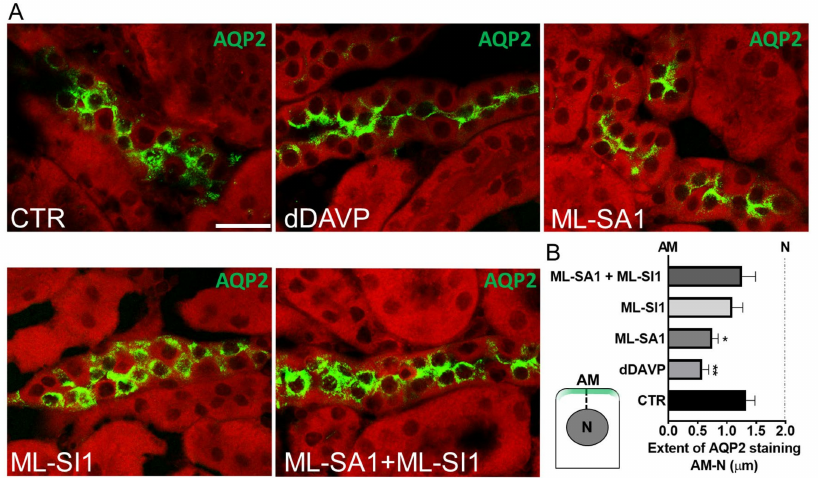
Figure 10. TRPML1 stimulation promotes AQP2 accumulation on the apical membrane of collecting duct cells of freshly isolated kidney slices. ( A ) Freshly isolated kidney slices from 6 wt mice were left untreated (CTR, complete medium) or stimulated for 45 min in complete medium as follows: 100 µ M dDAVP; 100 µ M ML-SA1 alone or after 30 min of preincubation with 25 µ M ML-SI1. Confocal images of kidney sections stained with an antibody against AQP2 (green) and counterstained with Evans blue (red). The images are representative of three independent experiments. Scale bar: 10 µ m; ( B ) A schematic representation of the approach used to quantify the extent of AQP2 fluorescent signal (green region) along a dotted line drawn from the apical membrane (AM) to the nucleus (N). The histogram summarizes the effects of treatments on the extent of AQP2 signal from the AM to N. For each experimental condition a total of n = 300 cells were blindly analyzed ( n = 50 cells for each mouse). The graph shows mean ± SEM, and significant differences were calculated with respect to the control condition by ordinary one-way ANOVA and Dunnett’s multiple comparisons